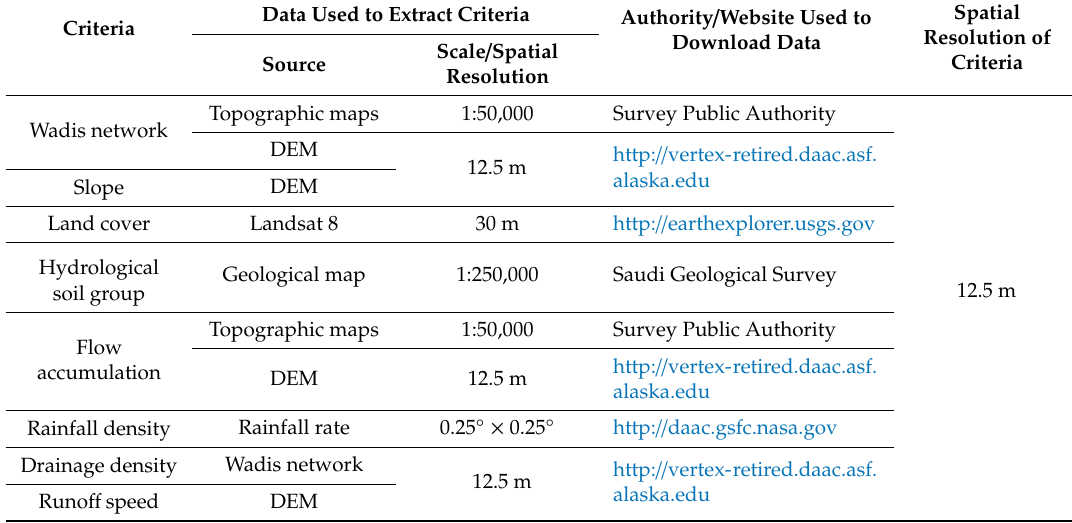
Table 2. Description of the data sets used in this